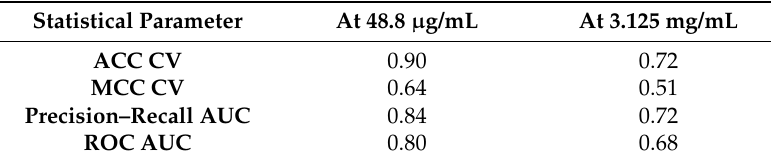
Table 2. Cross-validation scores for the binary GB classification models a . Statistical